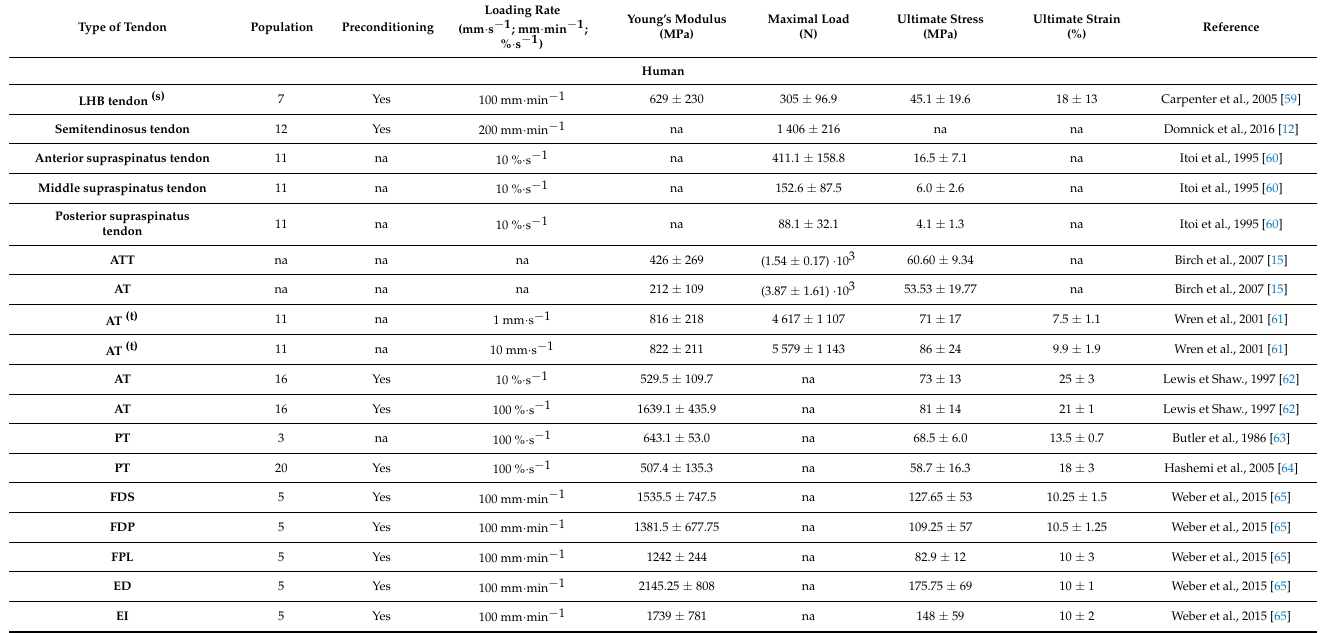
(s) Failure strain value referred to tendon substance. (t) Values referred to a pooled population